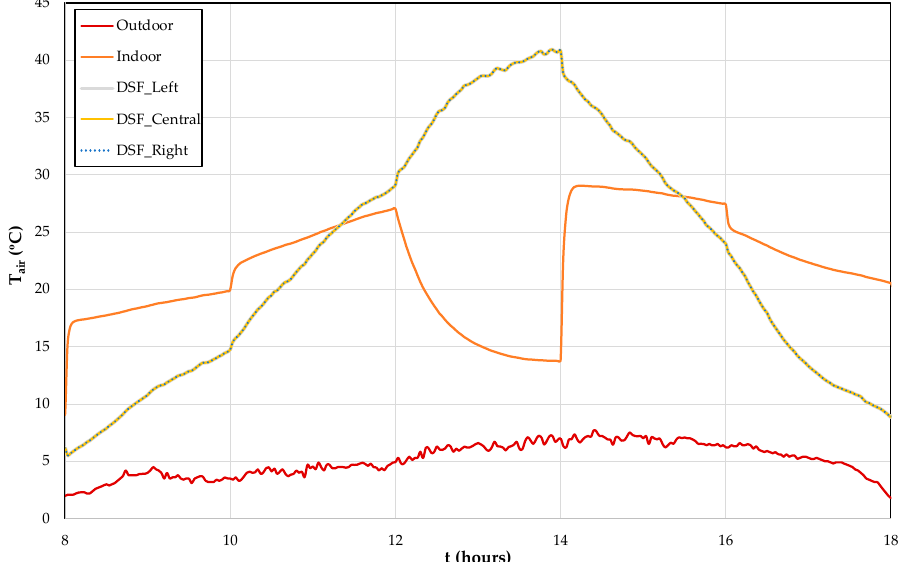
Figure 17. Evaluation of air temperature (T air ) of the outdoor environment, indoor virtual chamber and indoor left, central and right DSF system, when the airflow rate is variable and the number of DSFs to operate is constant, for the Case E.